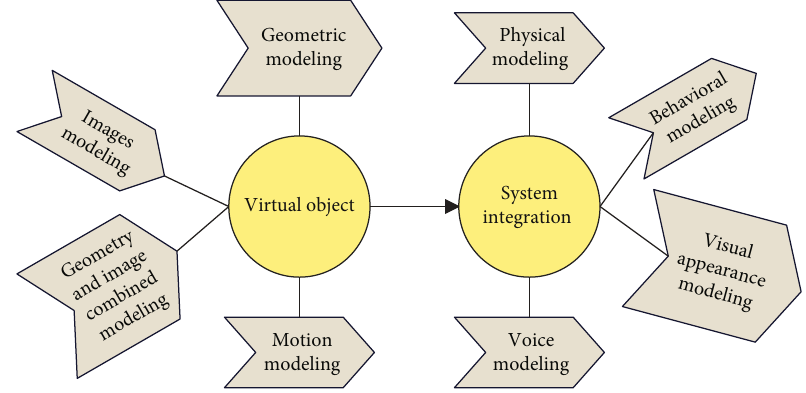
Figure 8: Classi fi cation of modeling methods.